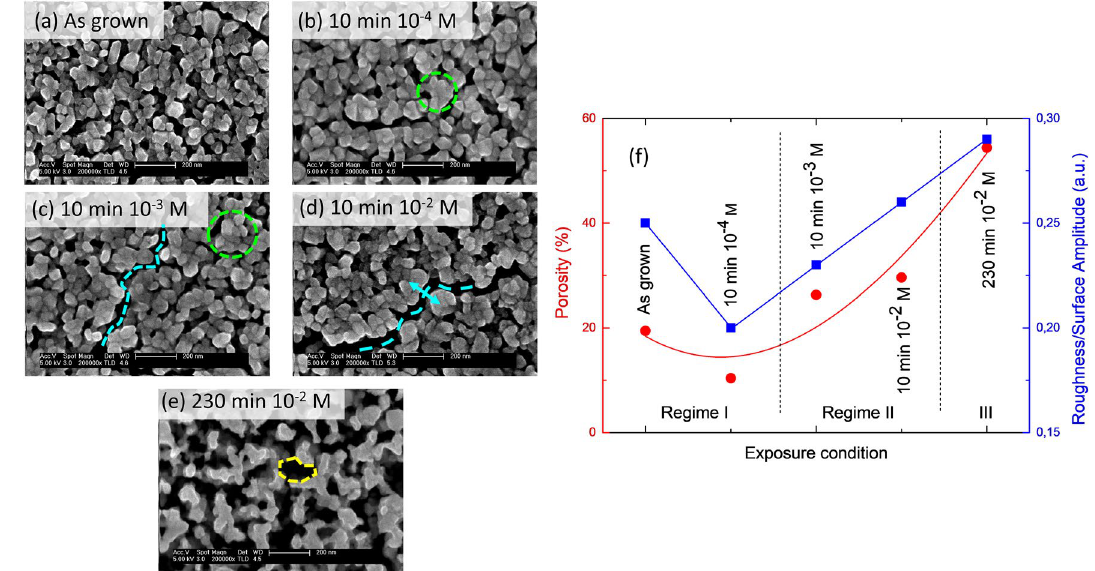
Figure 2. Evolution of the LCO thin film structure imaged by SEM for different exposure conditions to oxalic acid. Scale bar in ( a – e ) corresponds to 200 nm. Regions enclosed by a dashed green contour in ( b ) and ( c ) correspond to bundles of coalescing grains. Dashed light blue curves in ( c ) and ( d ) depict grooves. The blue arrow in ( d ) highlights the widening of the grooves. The dashed yellow section in ( e ) highlights the cross-section of a channel. ( f ) Roughness and film porosity for different exposure conditions. Curves serve as a visual guide. Figure created with WSxM 5.0 Develop (http:// www. wsxm. es) 15